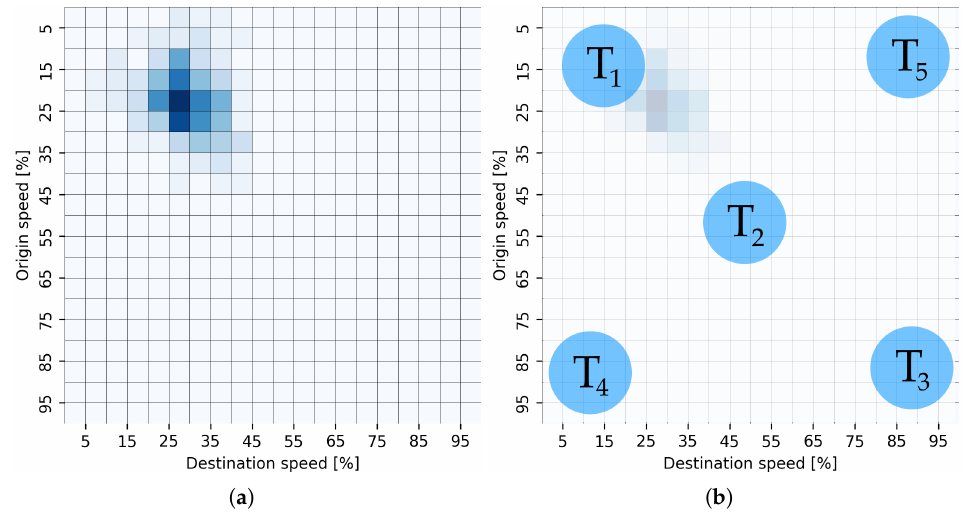
Figure 2. Examples of STMs representing congested traffic flow ( a ) and characteristic positions at STM ( b